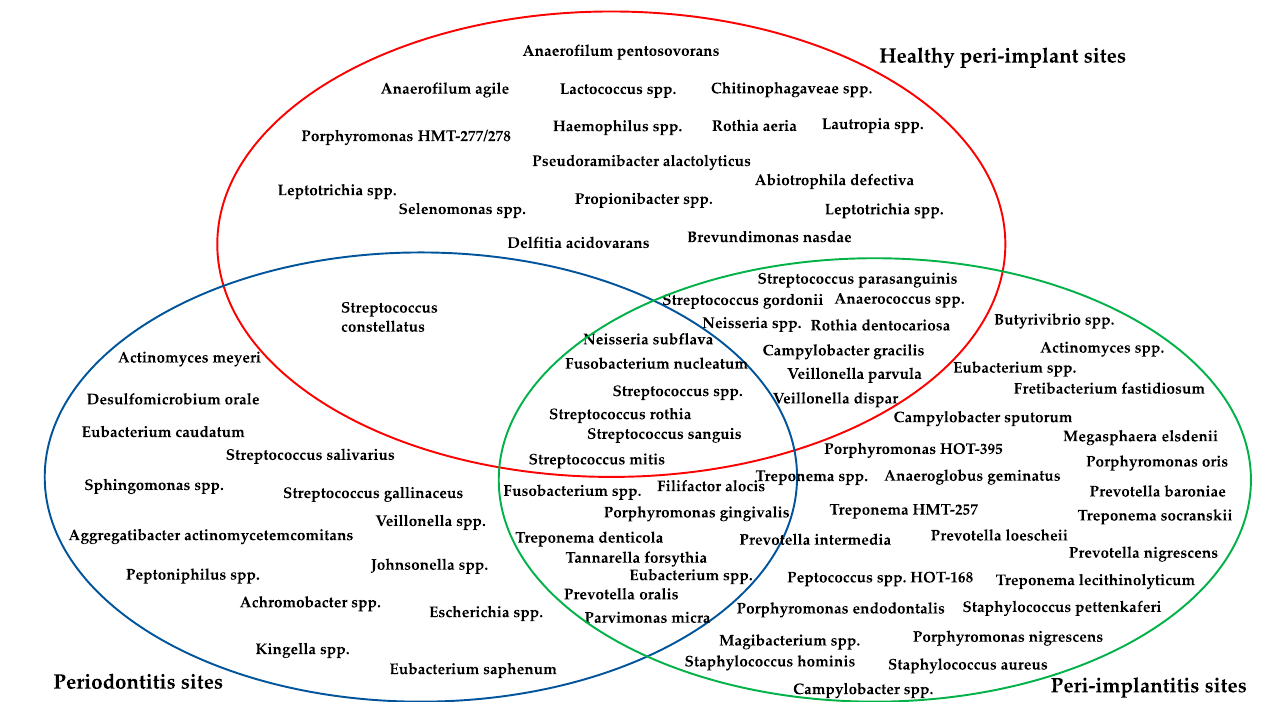
Figure 2. Bacterial species in healthy peri-implant sites and with peri-implantitis, in sites with periodontitis, and in common between the two sites [26,27,29,31–35,37].